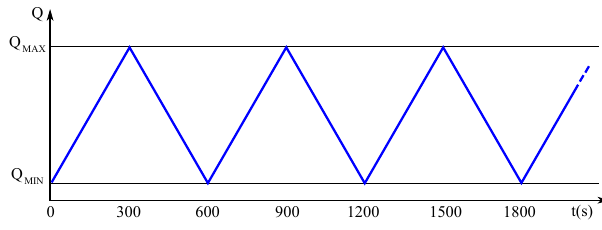
Figure 8. Comparision between numerical results (blue), experimental data (green dots) and numerical results from Kerger et al. (2010) (red dots) for the four gauges of the Wiggert test case setup.